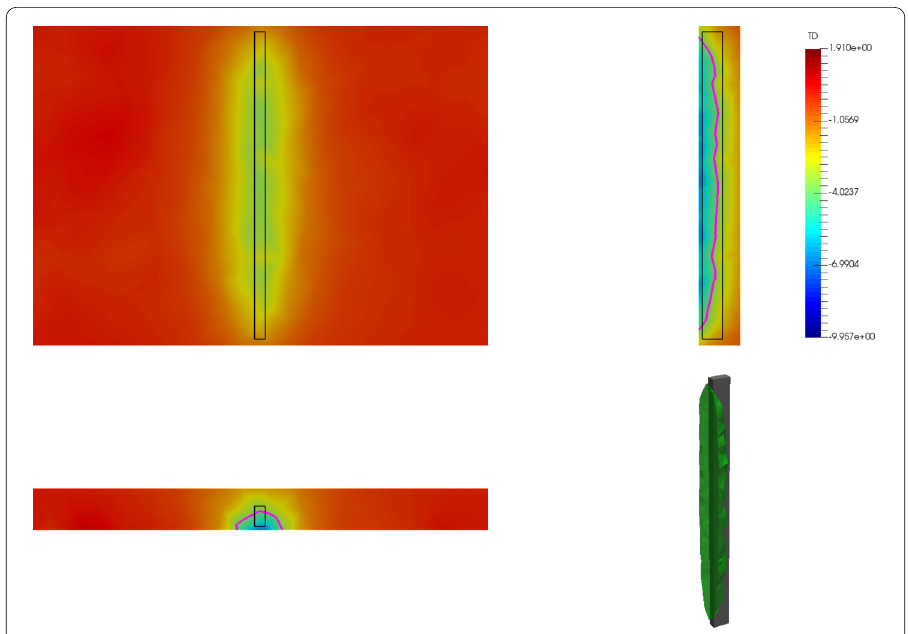
Figure 17 Reconstruction of the groove-shaped defect. Upper left: Topological derivative at x = 0. Upper right: Topological derivative at y = –0.125. Lower left: Topological derivative at z = –0.25. Lower right: Perspective showing the reconstruction for λ = 0.4 and the original defect